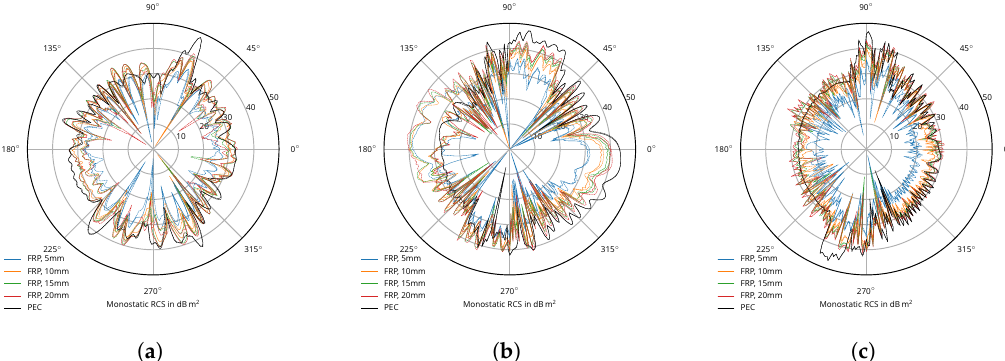
Figure 3. Monostatic RCS (in dBm 2 ) of the blades made of perfect electric conductor (PEC) material. Continuous lines: V polarization; dashed lines: H polarization. The different blades show very different characteristic RCS signatures. An increase of the physical size of the blades causes a small shift of the characteristic locations as well as a small increase of the RCS. The polarization of the incident field has no effect on the RCS. ( a ) Blades v1, v2, and v3; ( b ) blade v2, scaled; and ( c ) blade v3, scaled.